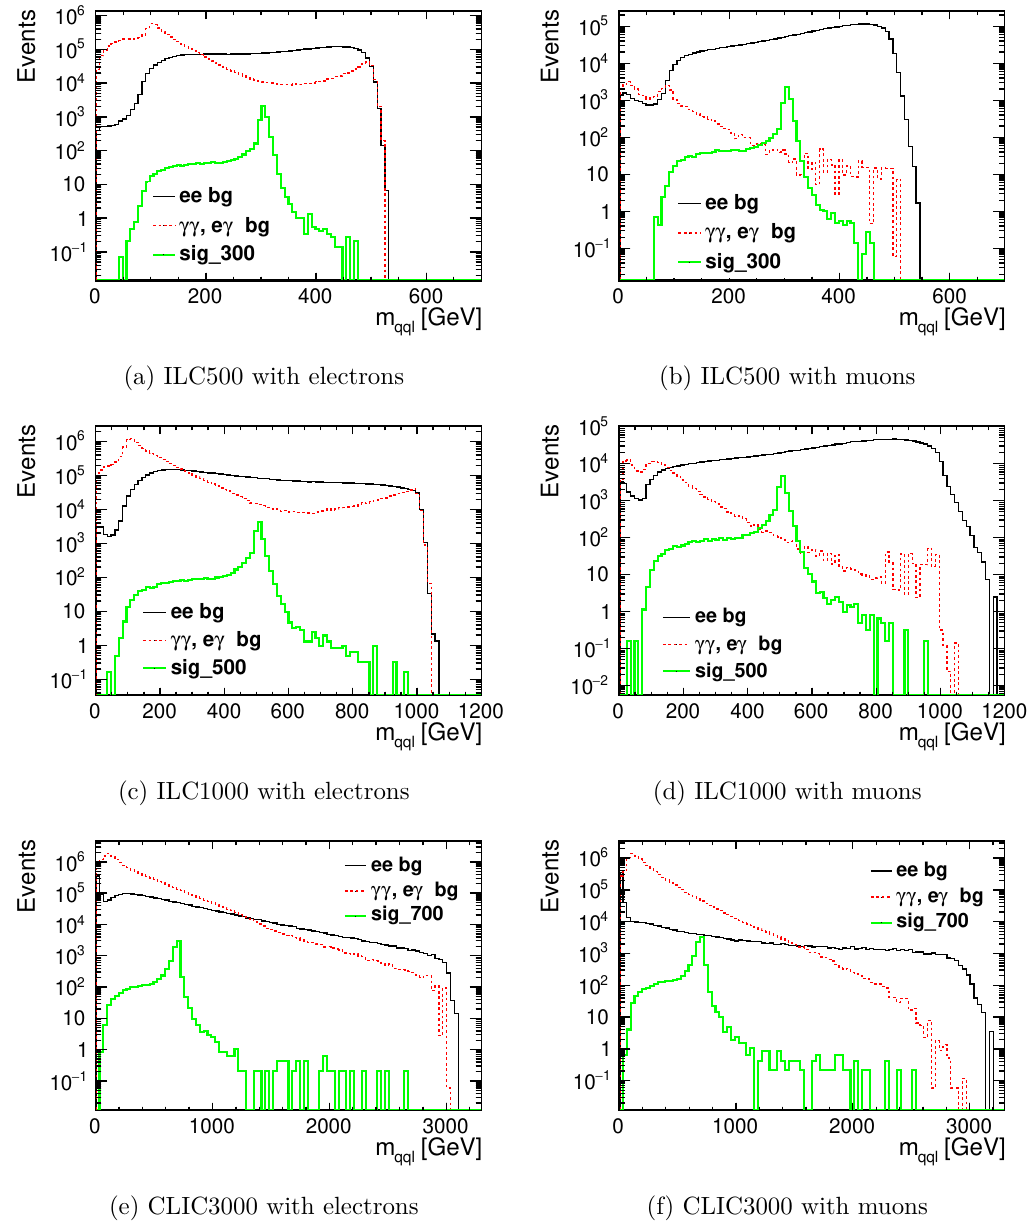
Figure 5. qq‘ mass distribution for different collider setups for electrons (left) and muons (right) in the final state, respectively. Black solid lines stand for the e + e − background, red dashed lines for the γ -induced background and thick green lines for the different signal scenarios — results for Dirac neutrinos with masses of 300 GeV, 500 GeV and 700 GeV are presented for ILC500, ILC1000 and CLIC3000,